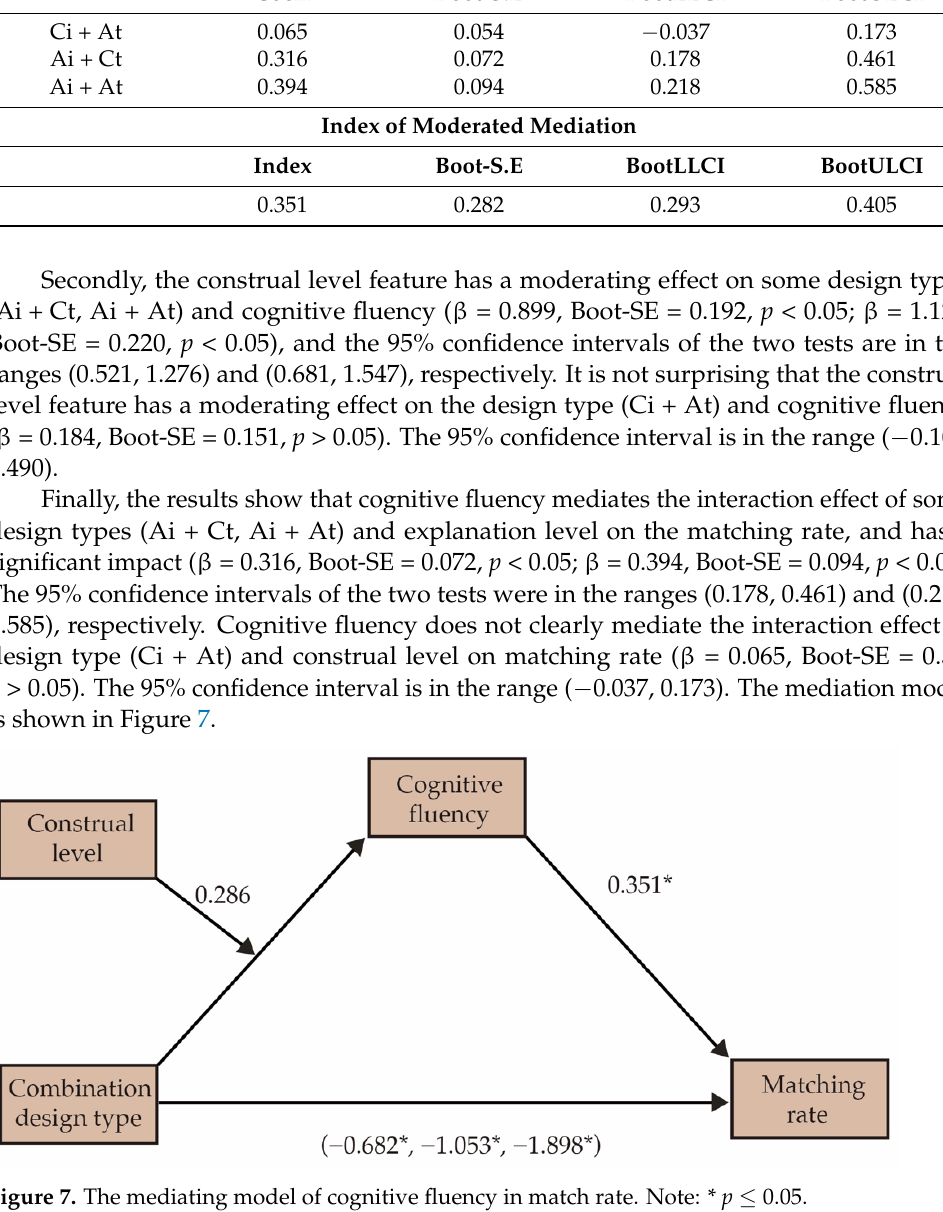
Figure 7. The mediating model of cognitive fluency in match rate. Note: * p ≤ 0.05.